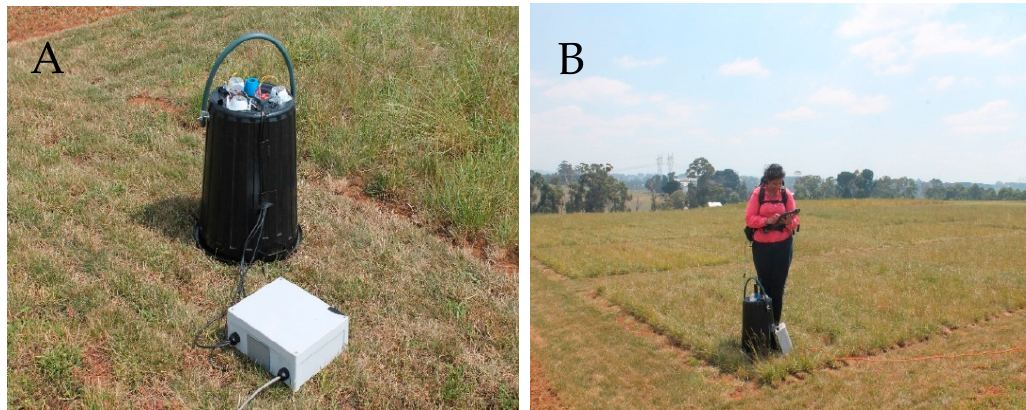
Figure 2. ( A ) The light shield, showing the light fittings and the entrance point for the sensor, ensuring the lens will be held at a uniform depth and angle; ( B ) The light shield is moved over individual perennial ryegrass plants in the field and the spectra is recorded.